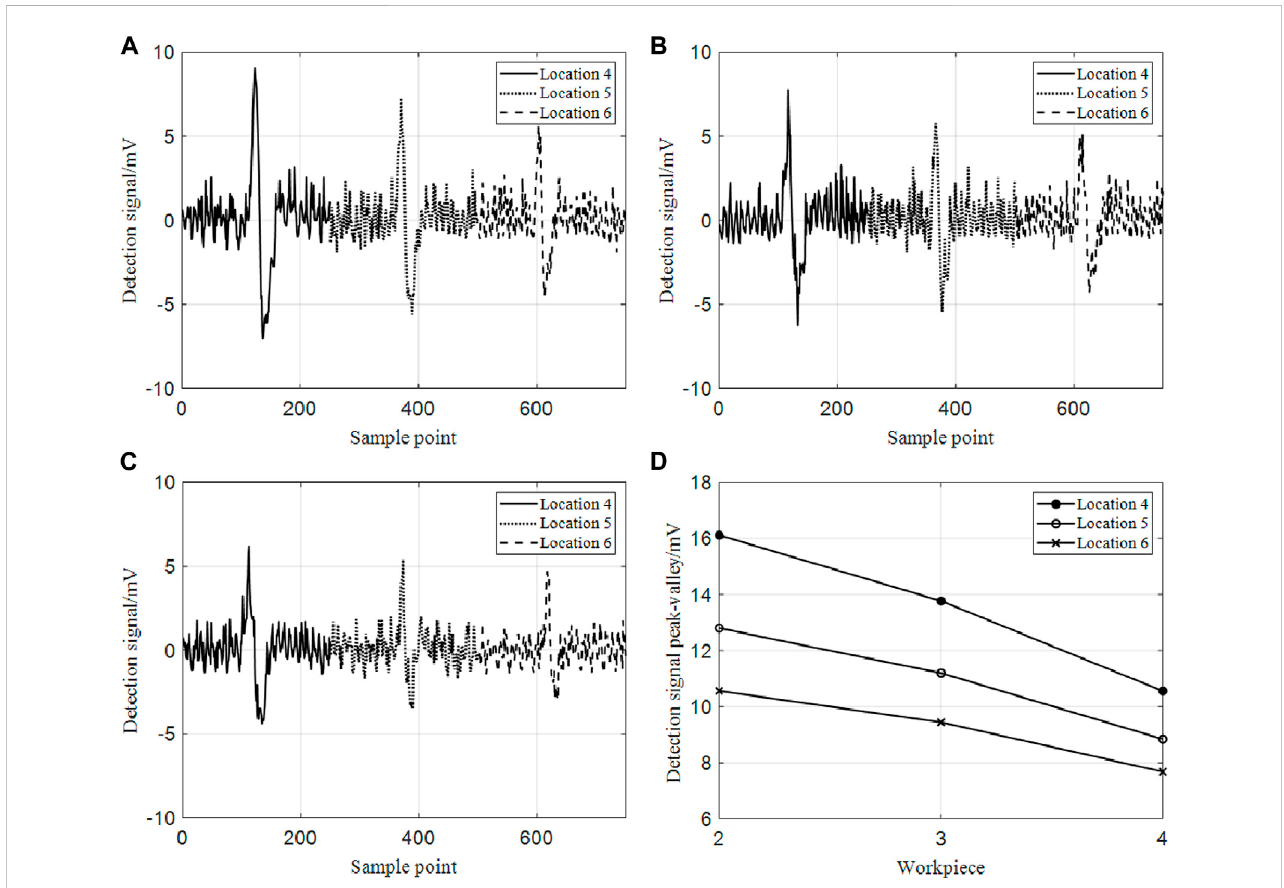
FIGURE 14 (A) The detection signal of workpiece two at differentradius of curvature; (B) The detection signal of workpiece three at different radius of curvature; (C) The detection signal of workpiece 4 at different radius of curvature; (D) Peak and valley values of the experimental signal of different models bearing rings at different